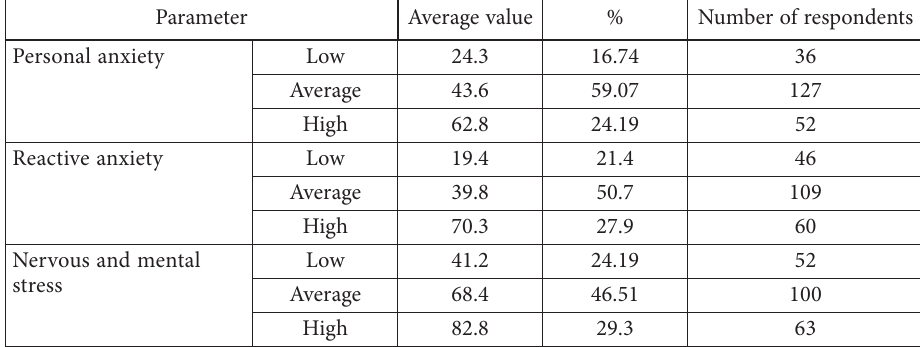
Table 2. Levels of anxiety and nervous tension among respondents (source: created by authors)